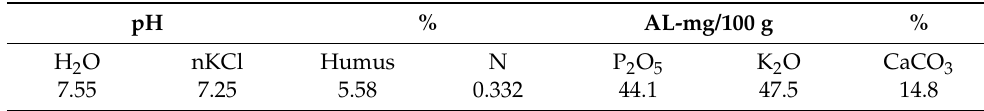
Table 1. Chemical properties of the soil used in the study.